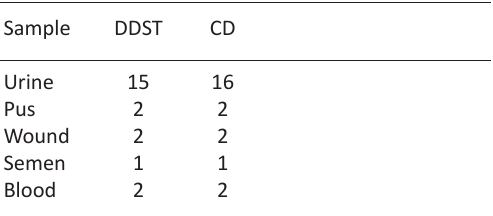
Fig. 5 . Extended-spectrum ß-Lactamase (ESBL) Positive Isolates by Combined Disc Test (CD) Table 1. The number of ESBL producing E. coli in various samples by phenotypic